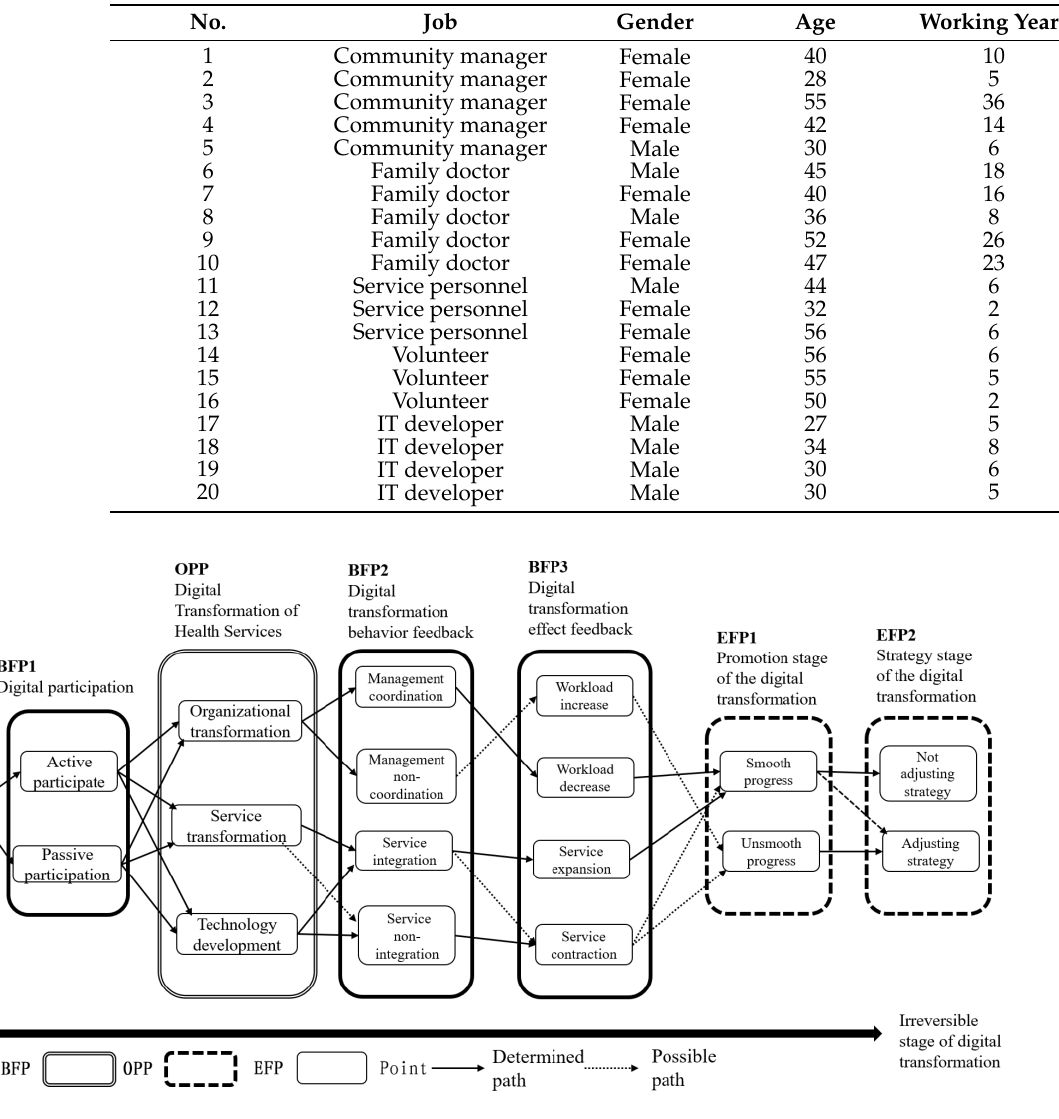
Figure 4. Time-series path of supply-side-based digital health service aging transformation. Among the interviewees on the demand side, 41.7% were men and 58.3% were women. The average age was 72.1 ± 7.2 years, and the length of residence was 20.6 ± 7.9 years (Table